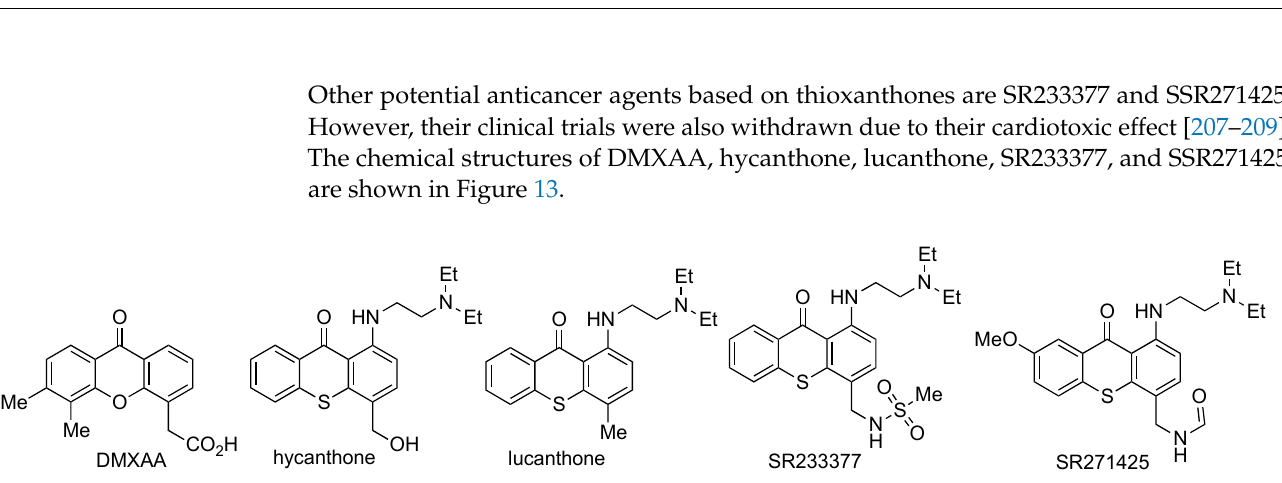
Figure 13. Evaluated xanthone derivatives as the anticancer agents through in vitro assay.